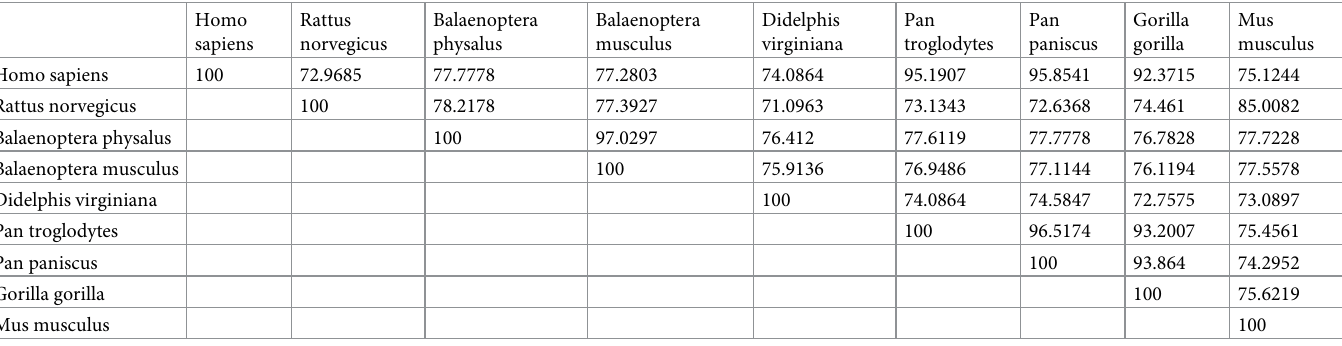
Table 5. The parameter Similarity of the Smith-Waterman algorithm in the quantitative measurement of homology. The Similarity measures the resemblance of two compared sequences (in percentage) aligned by the HELIOS method. Various amino acids are categorized into six groups based on their physicochemical properties; including GAVLI, FYW, STCM, KRH, DENQ, and P. Moreover, the “Nine ND5 protein sequences dataset” [53] is assumed in this study.